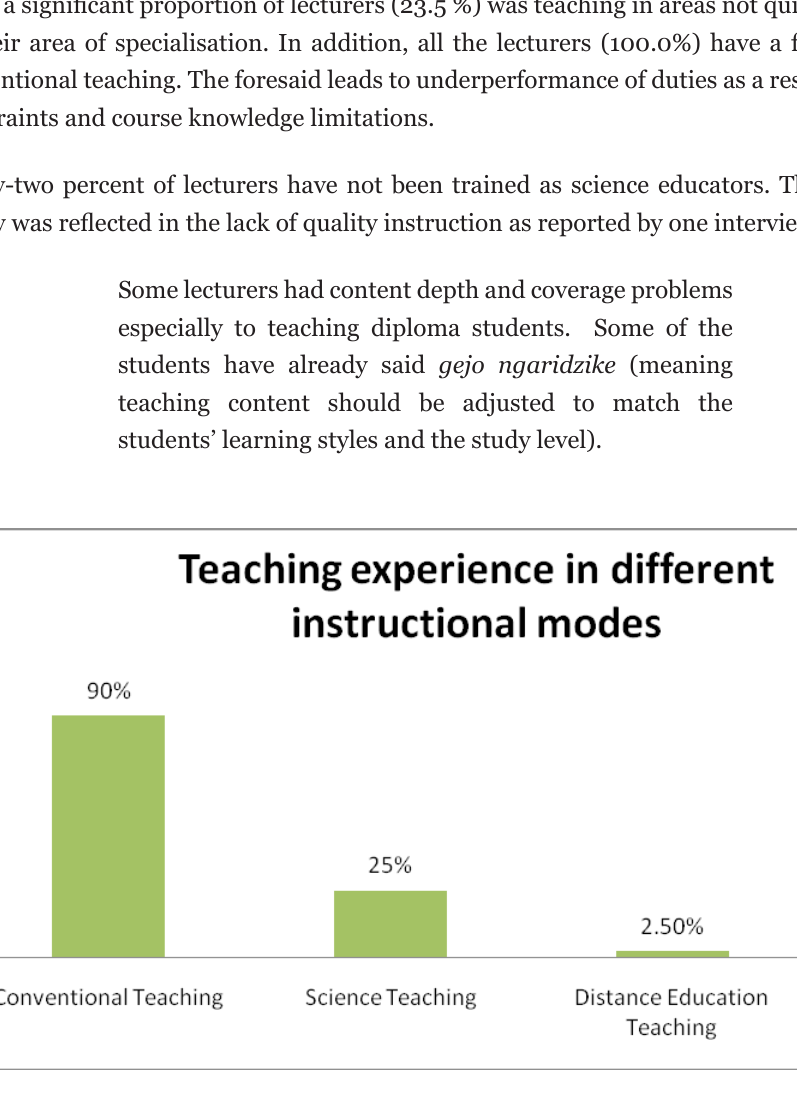
Figure 3. Showing the teaching experience of the lecturers in different instructional modes. Most of the lecturers (90.0%) have 1-3 years university conventional teaching and